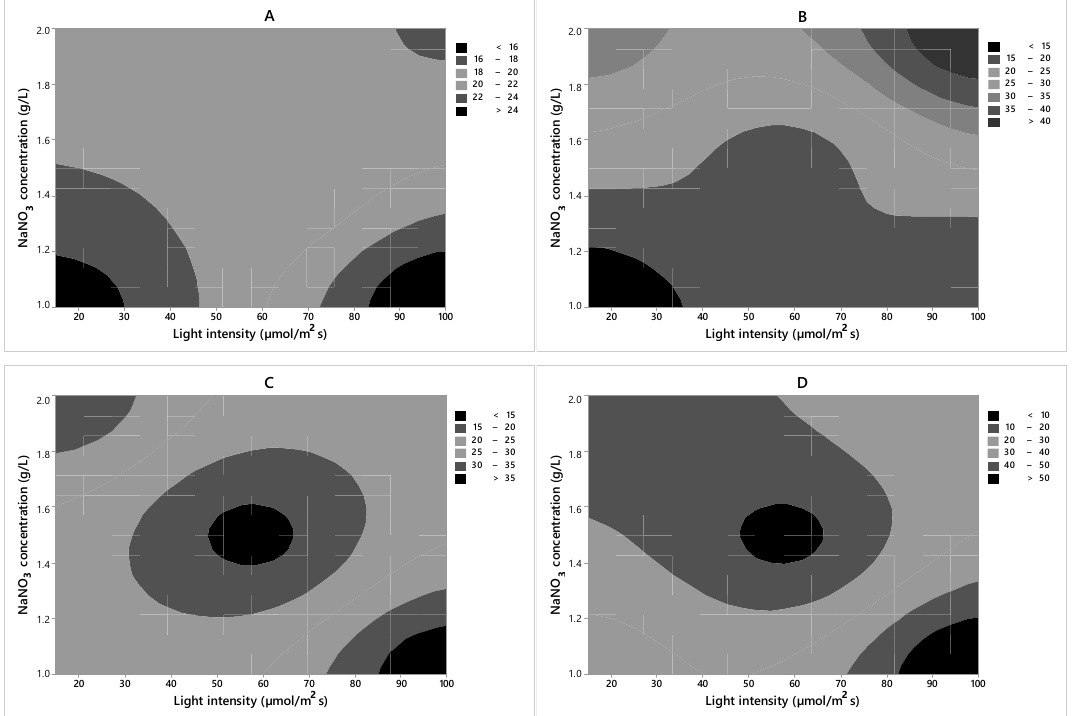
Figure 5. Level curves for the lipid content (%) as a function of the independent variables for each strain. ( A ) Synechocystis sp. CACIAM05; ( B ) Microcystis aeruginosa CACIAM08; ( C ) Pantanalinema rosaneae CACIAM18; ( D ) Limnothrix sp. CACIAM25.